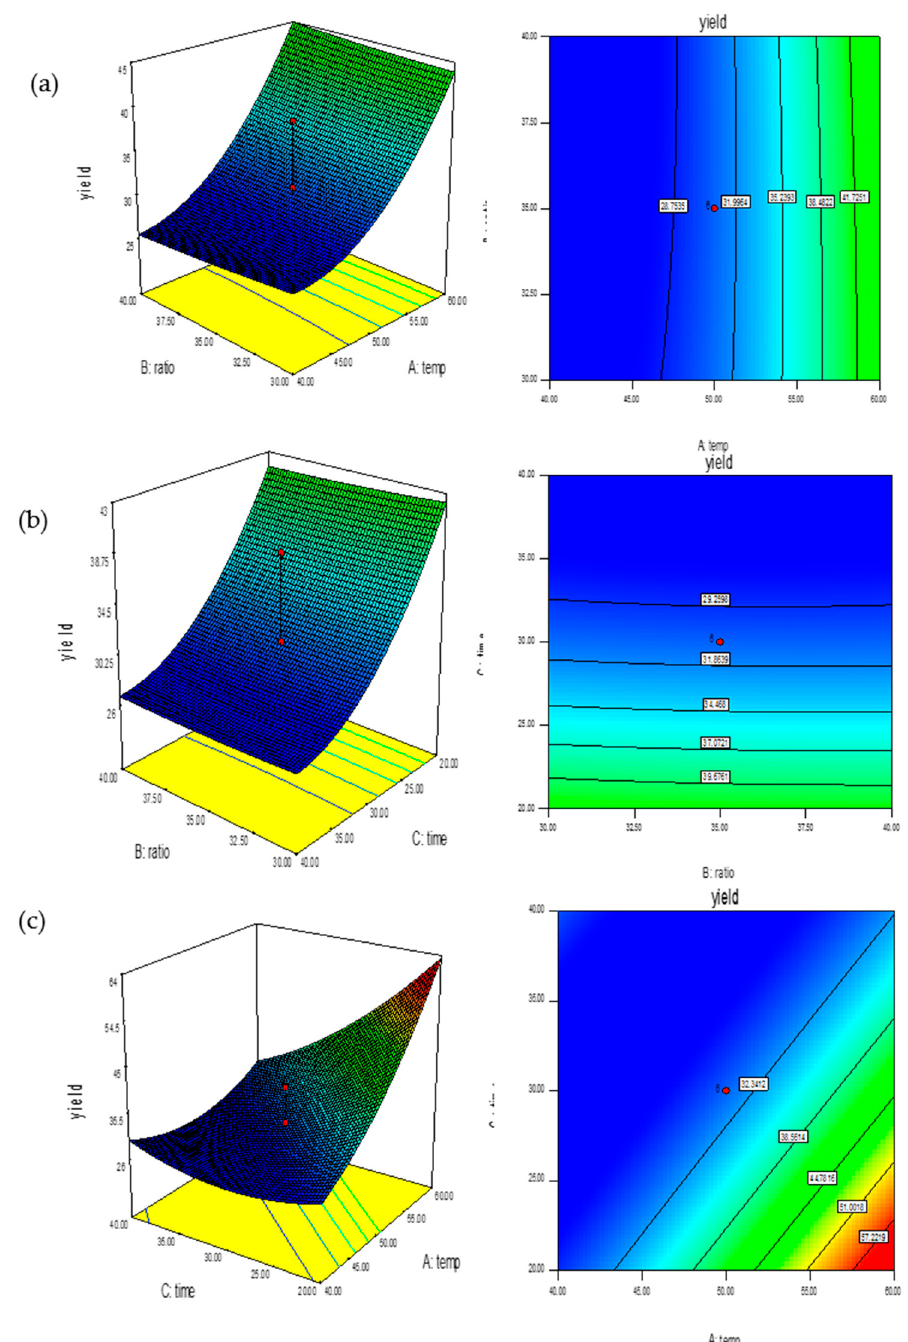
Figure 5. Response surface plots representing the effects of (a) A and B, (b) B and C, and (c) A and C on the yield of thymol. A, temperature; B, solid-to-solvent ratio; C, extraction time. Table 5. Residual calculation based on predicted and experimentally obtained results in optimal conditions.